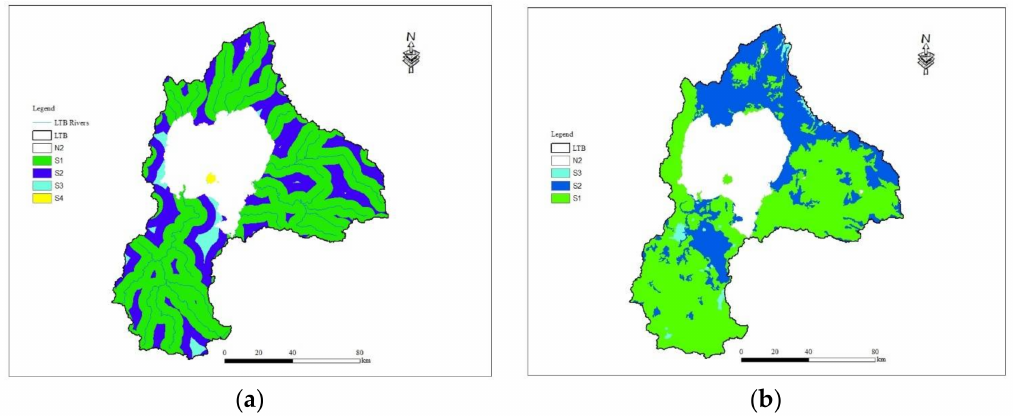
Figure 5. Reclassified factors ( a ) river proximity; and ( b ) soil capability index.